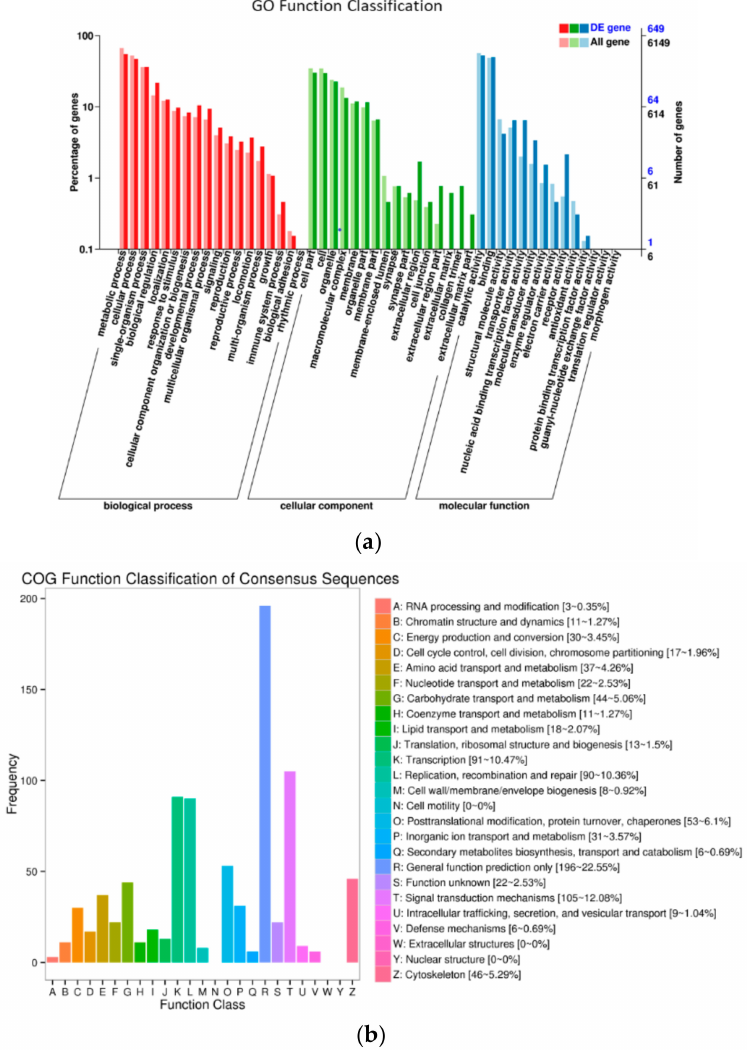
Figure 3. Functional annotation of DEGs of T. pisiformis transcriptomes in TpA versus TpM. ( a ) GO enrichment analysis of DEGs and ( b ) COG classifications of di ff erentially expressed genes (DEGs).